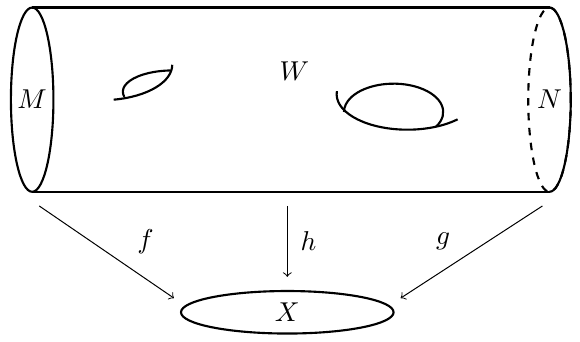
Figure 1 . Cobordism ( W, h ) between ( M, f ) and ( N, g )